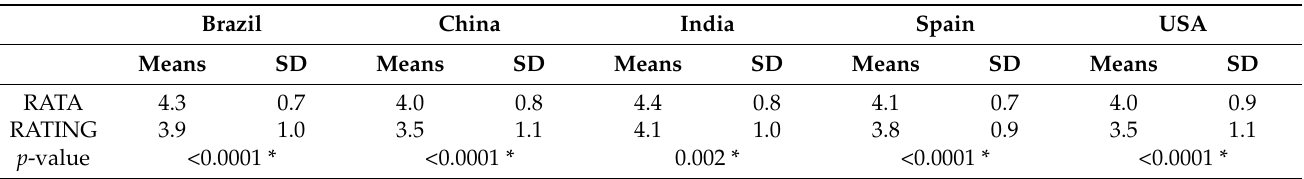
Table 8. Means † and p -values for survey liking for RATA and RATING per